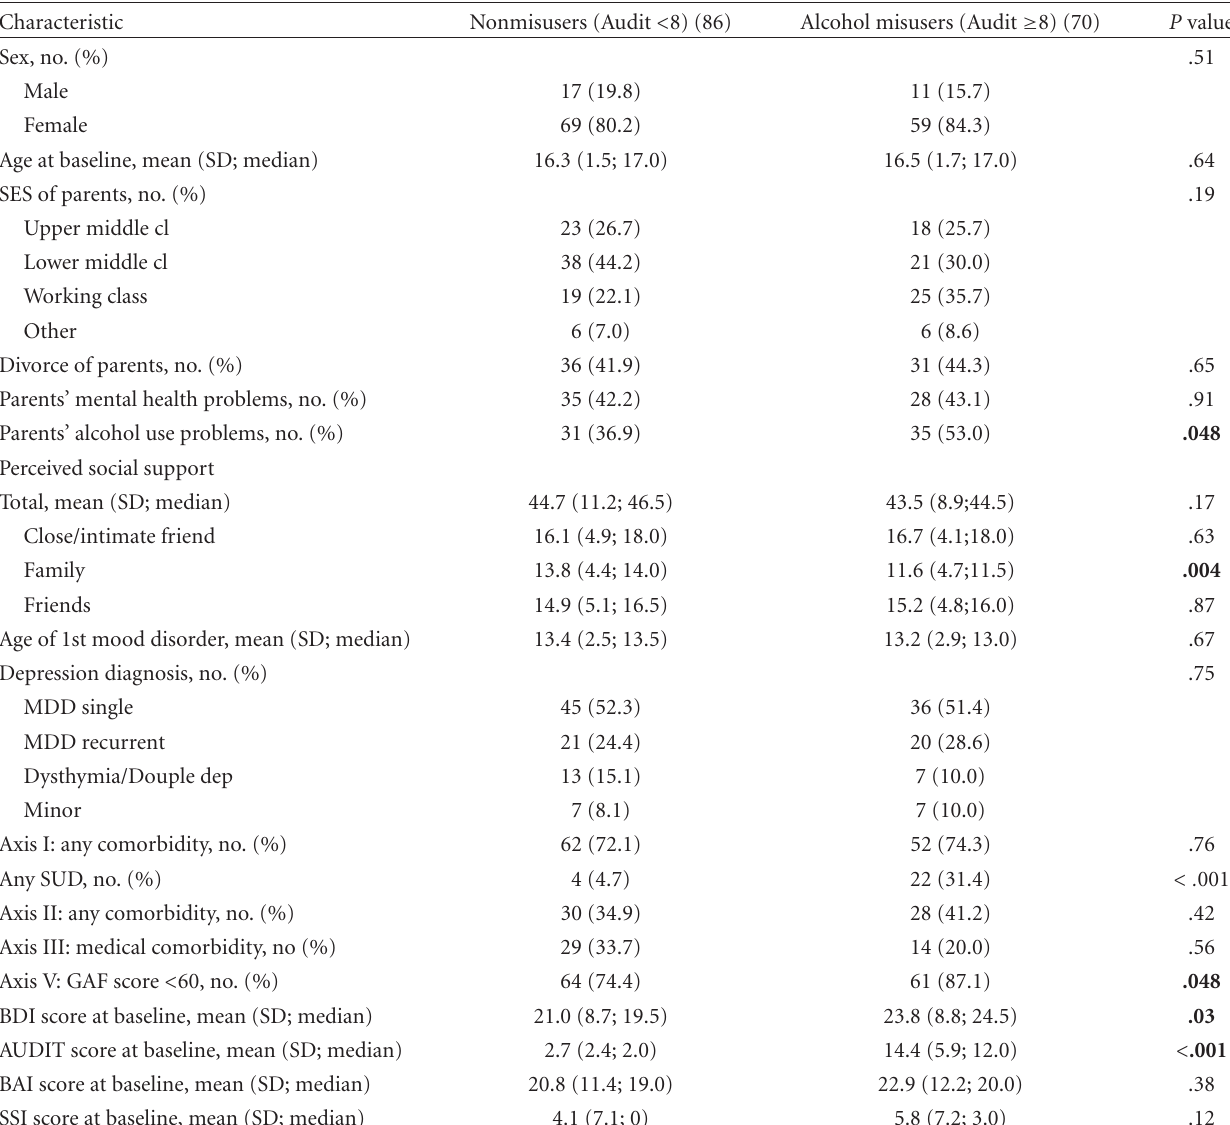
Table 1: Sociodemographic, diagnostic, and clinical characteristics of depressed outpatients by alcohol use at baseline ( n = 156). Characteristic